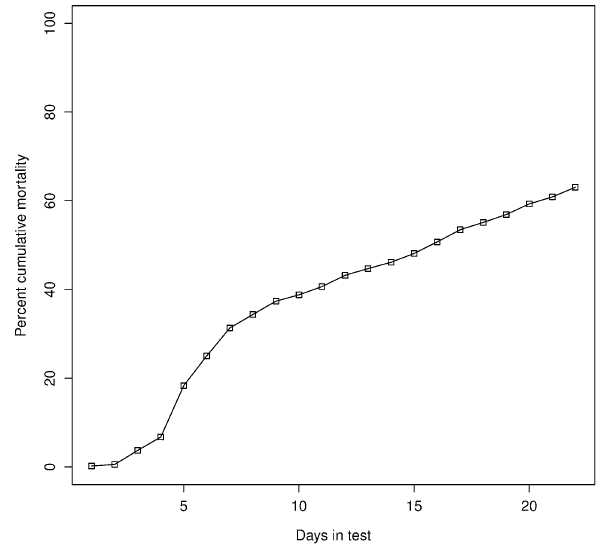
Figure 1. Cumulative mortality observed with WSSV infection among G 0 training animals. The total number of animals evaluated in the challenge test was